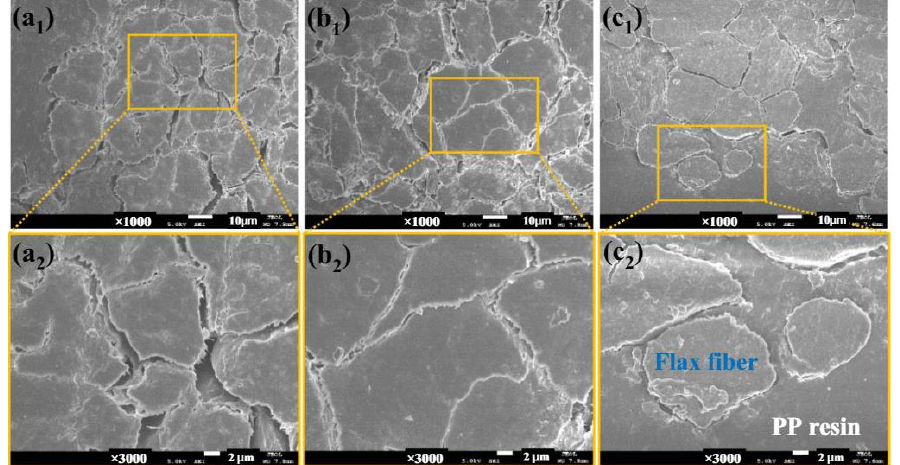
Figure 4. Morphology of flax/PP composites: ( a 1 , a 2 ). untreated flax/PP composites, ( b 1 , b 2 ). alkali- treated flax/PP composites, and ( c 1 , c 2 ). alkali silane-treated flax/PP composites (Adapted from the reference [48]).